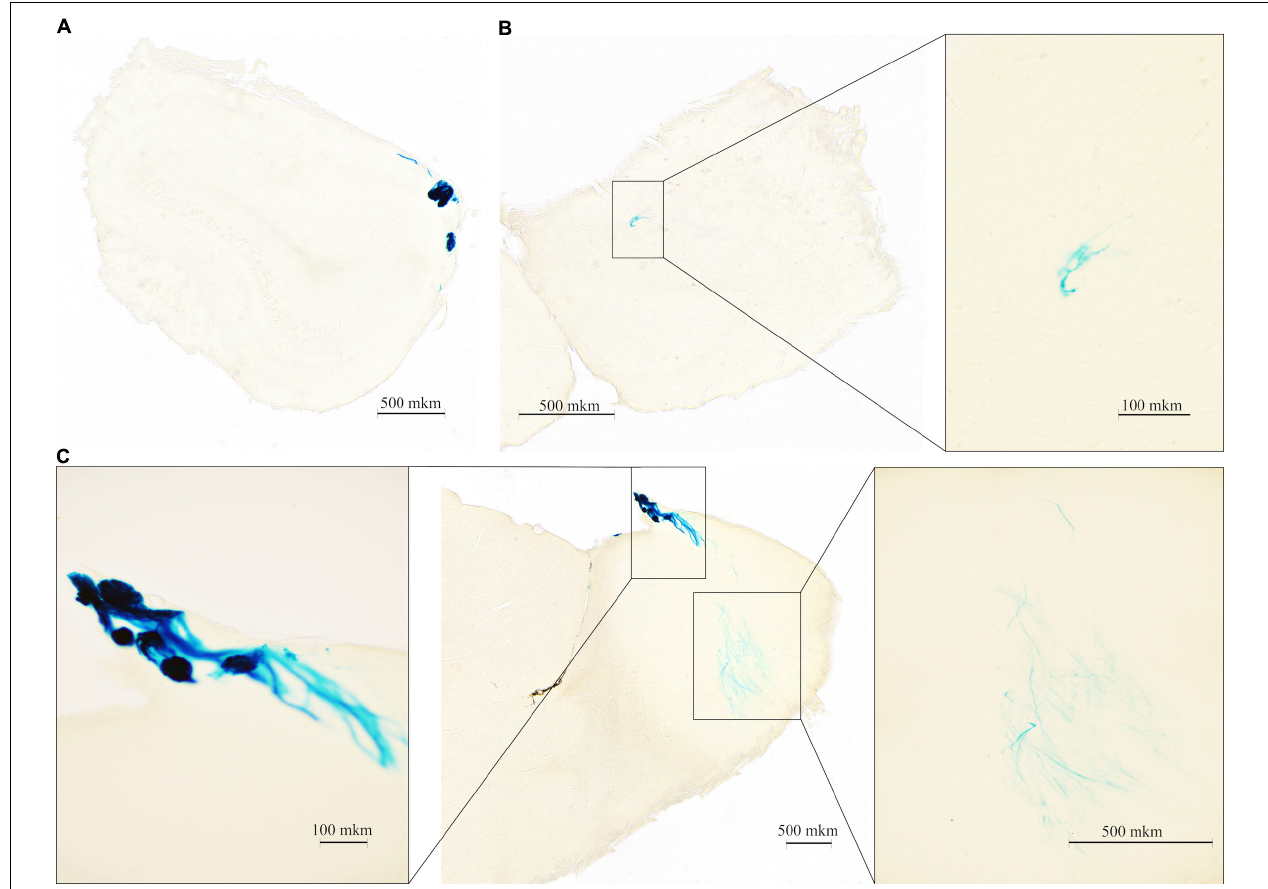
FIGURE 2 | | Beta-galactosidase (LacZ) staining shows TAAR2 expression in the mouse olfactory bulb (OB) presented in the frontal and sagittal sections. TAAR2 expression was observed in the glomerular ( A,C left) and inner ( B,C right) layers of the OB. Scale bar—500 µ m ( A–C,C right); 100 µ m ( B right, C